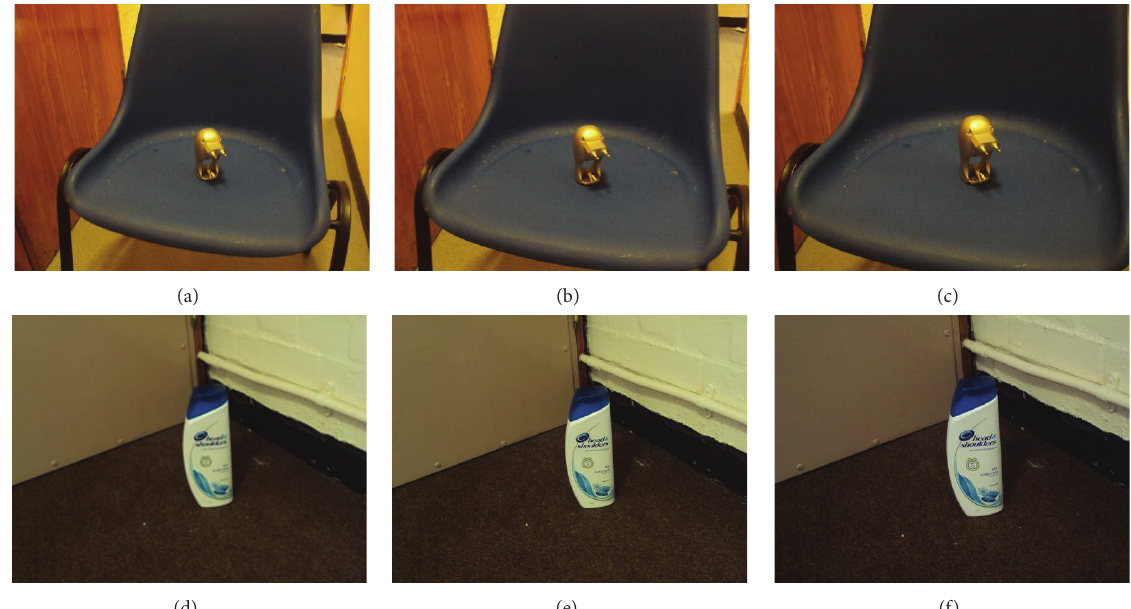
Figure 5: Images with scale differences. First image in each row is selected as reference image and matched with test images (second and third in the row).